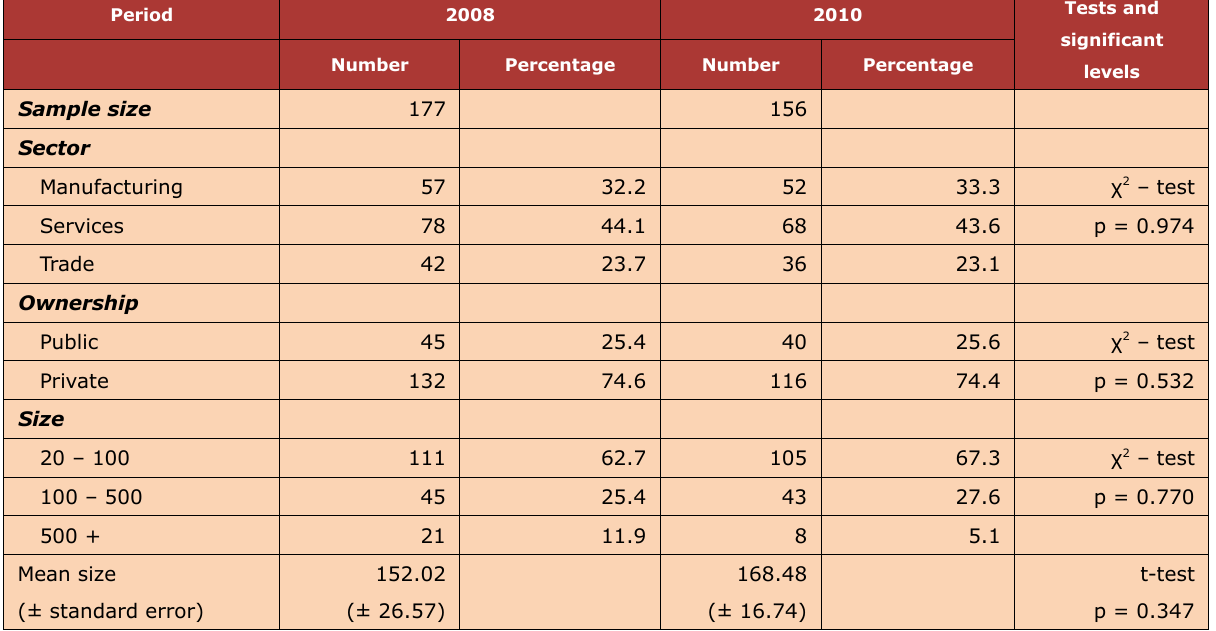
Table 1. Sample demographics with respect to